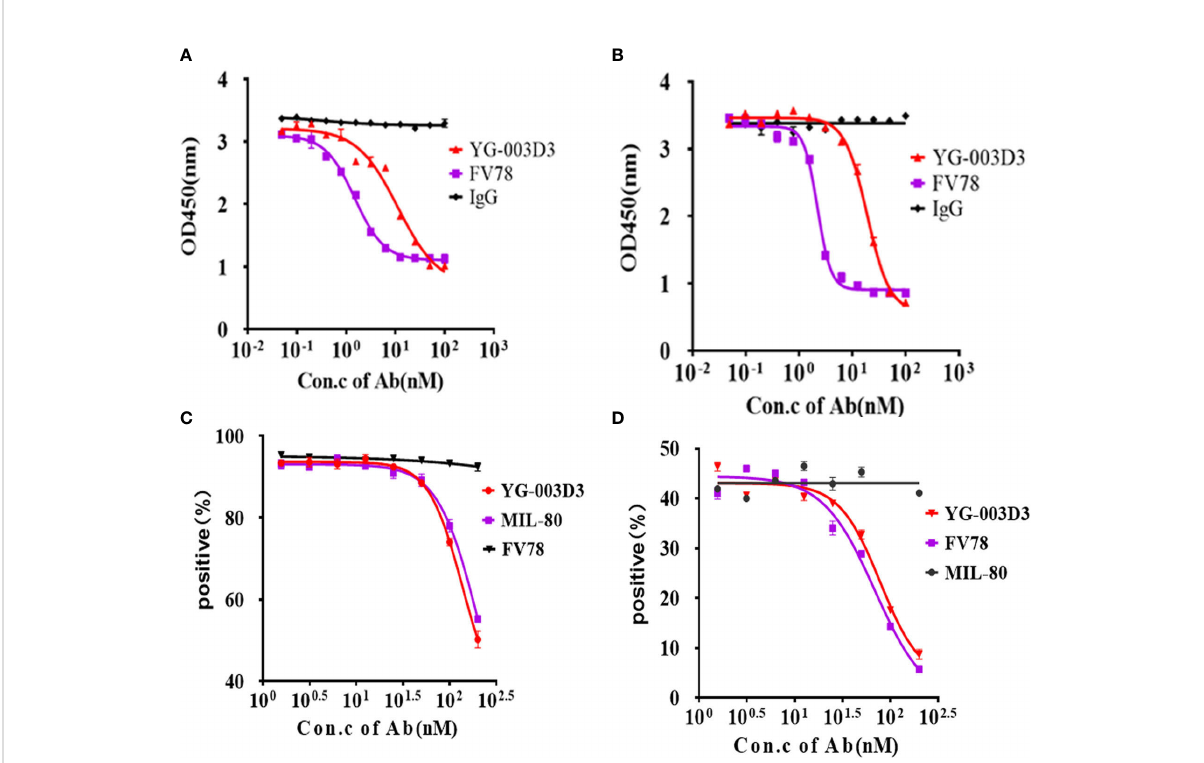
FIGURE 3 YG-003D3 blocks the interaction between PD-1/PD-L1, PD-1/PD-L2, and LAG-3/MHC-II. (A) Competitive ELISA assay to test the blocking activity of YG-003D3 on the interaction of PD-1/PD-L1. (B) Competitive ELISA assay to test the blocking activity of YG-003D3 on the interaction of PD-1/PD-L2. (C) Flow cytometry to test blocking activity of YG-003D3 on binding of LAG-3-biotin to Raji cells (Constitutive expression